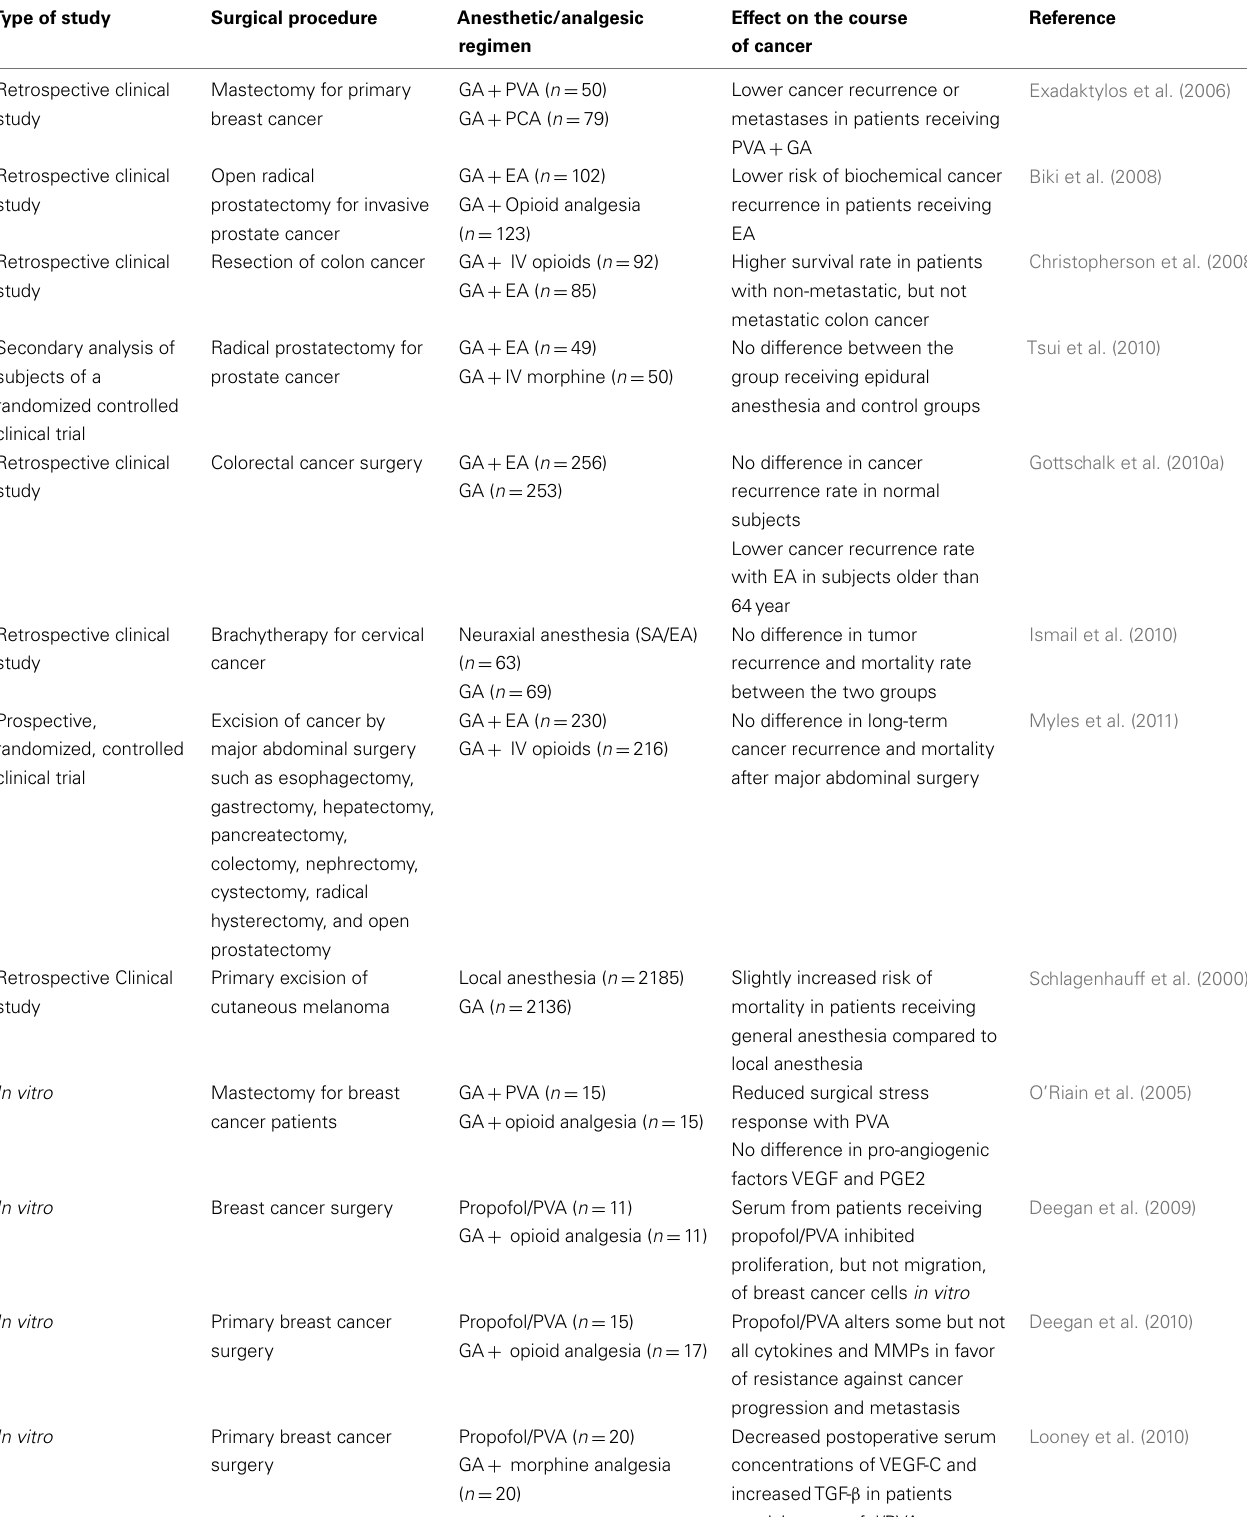
Table 2 |The effect of perioperative anesthetic/analgesic technique on cancer recurrence and survival. Type of